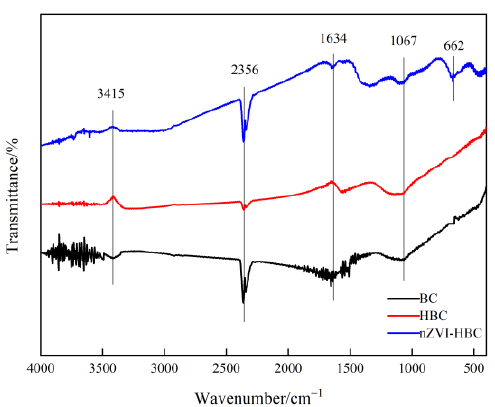
Figure 3. Fourier-transform infrared spectroscopy of biochar.